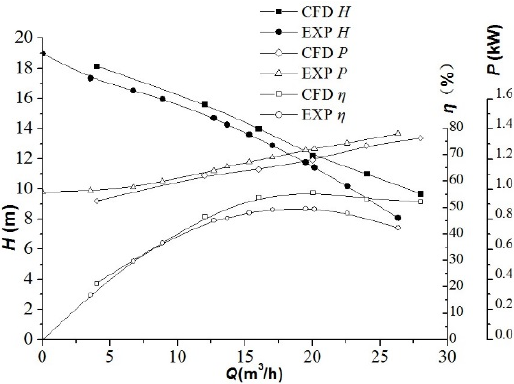
Figure 5. Pump performance.